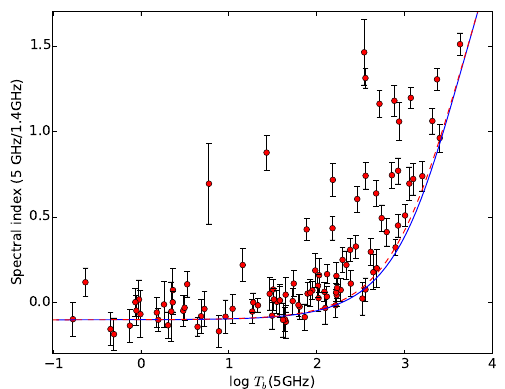
Figure 1. The 5 GHz to 1.4 GHz spectral index as a function of brightness temperature at 5 GHz for uniform (blue line) and spherical models (red dashed line) for T e =